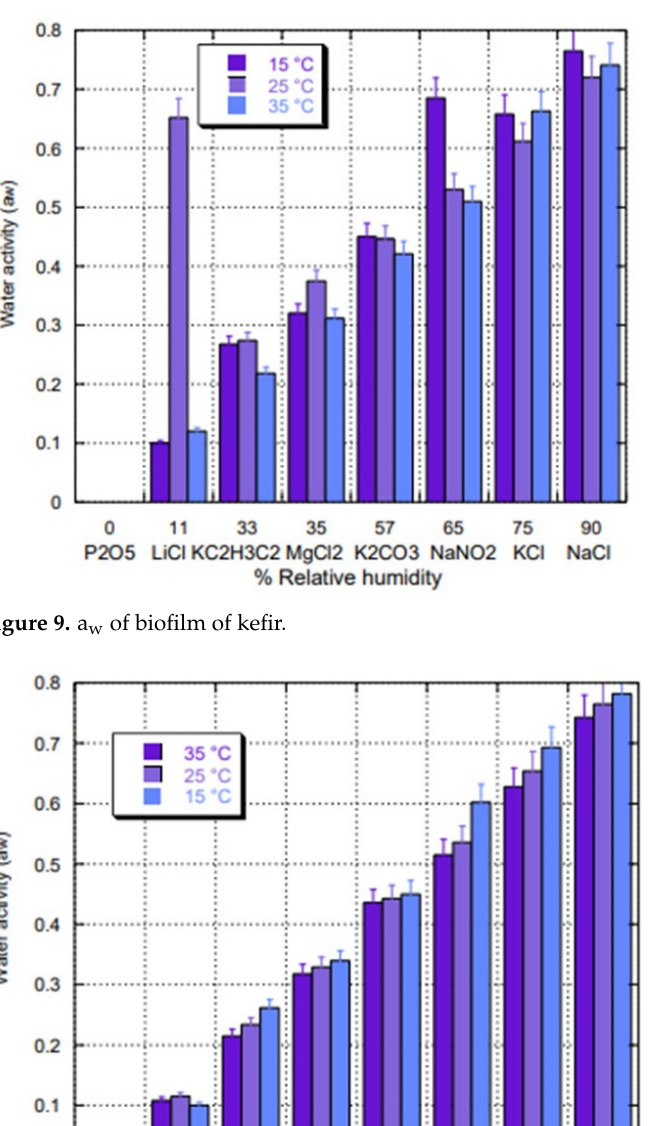
Figure 11. a w of edible film of cassava starch. The results demonstrated that there is microbiological stability with some atmos- pheres modified by salts due to their water activity since the level is below 0.6. However, unlike conventional starch films, exceeding the value of 0.6 for the biofilm of kefir grains is adequate due to its composition of probiotic microorganisms. All experiments show that, if biofilms are exposed to relative humidity above 75%, there are many possibilities for microorganisms to develop in them. In Figure 9, a higher water activity is observed at low temperatures since the microorganisms present in the biofilms of kefir grains are benefited by their development at this temperature and, at higher temperatures, there is also some increased water activity. The relationship between relative humidity and temperature has not been studied more deeply; thus, a research gap is opened for future work with kefir grain biofilms. It is also observed that a relative hu-